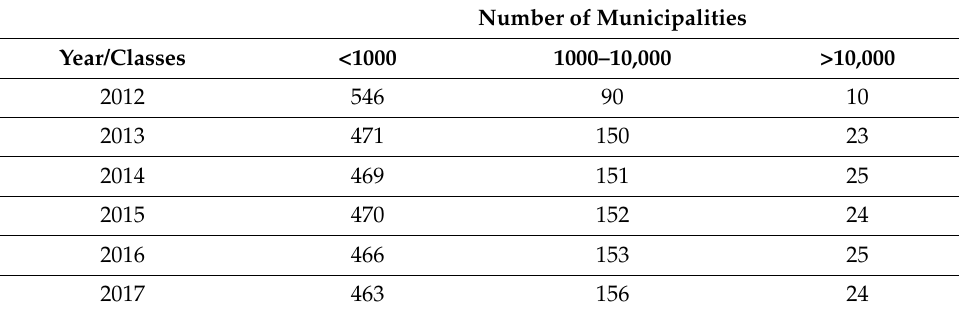
Table 4. Municipalities classify by the number of MSW truck’s vehicles